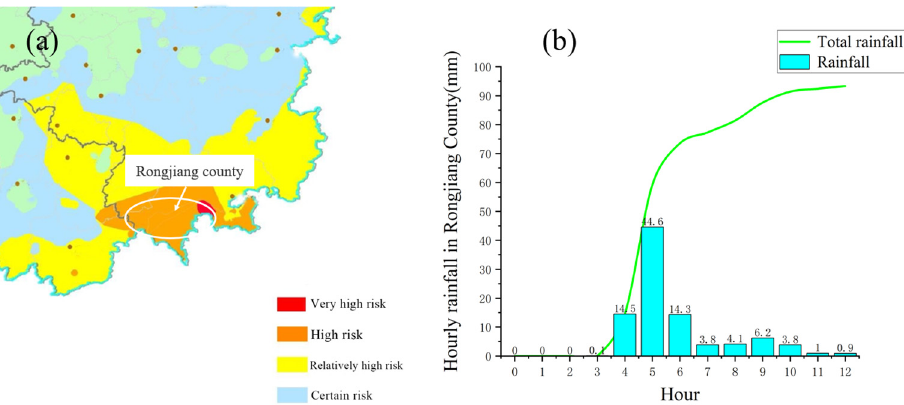
Figure 6. Rainfall situation: ( a ) Rain warning map of Rongjiang County the day before the accident; ( b ) Rainfall in Rongjiang County within 12 h by time.